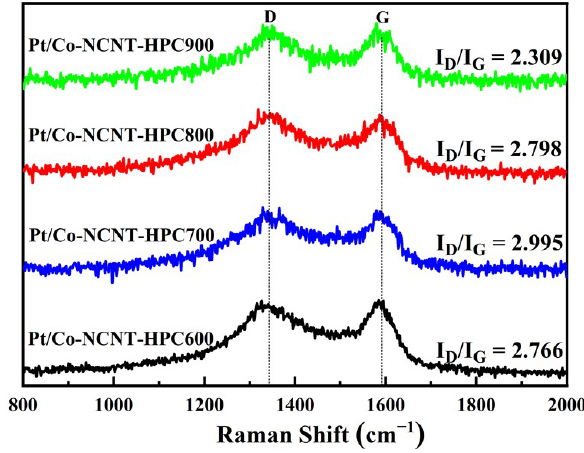
Figure 6. Raman spectra of Pt/Co-NCNT-HPC catalysts.